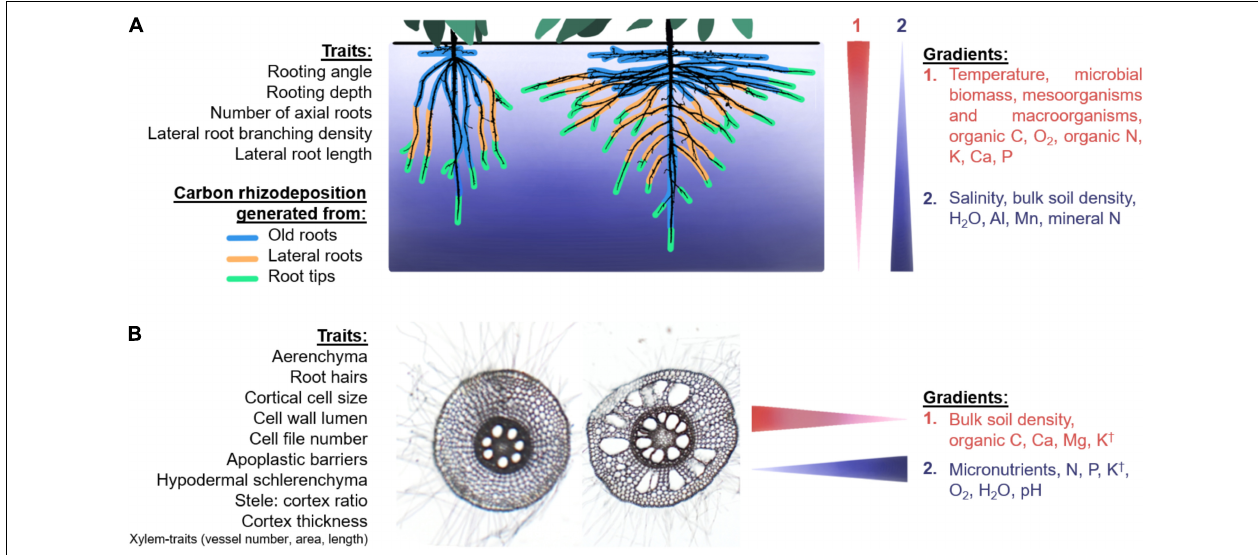
FIGURE 2 | Hypothesized modifications of microhabitats in the endosphere and rhizosphere caused by vertical (A) and horizontal (B) soil gradients, shown as narrow triangles (on right) to indicate the direction of the gradient. (A) Two common-bean root systems with contrasting root architectures (modified from two actual root images courtesy of Dr. Magalhaes A. Miguel). The colors around the roots represent different origins of carbon rhizodeposition, with old roots shedding tissue from secondary growth and root exudates. Deep rooting systems deposit different composition of exudates in deeper soil layers due to the increase in root tips in deeper locations. (B) Two root cross-sections of maize taken in the same spot within the root crown in two different plants showing differences in root anatomy. Anatomical phenotypes and environmental gradients that we hypothesize to be related to microbial associations in the rhizosphere or endosphere are listed in regular font size, although indirect effects of the phenotypes listed in small-sized font with the gradients may also be expected. † K effect can vary between different sites with different soil physicochemical conditions. Details on the specific root phenotypes and their interactions with microbes are provided in the